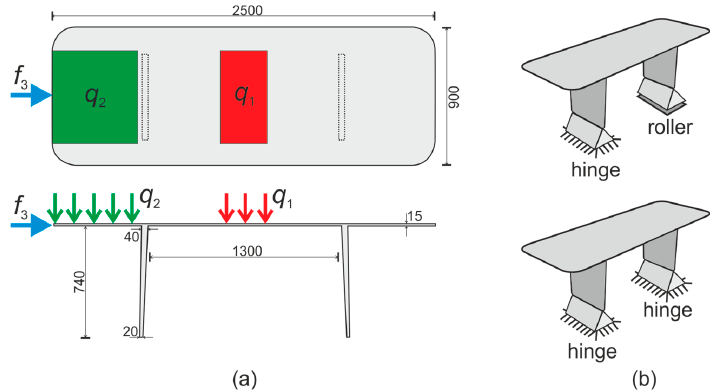
Figure 6. ( a ) Table geometry and loading conditions. ( b ) Boundary conditions.